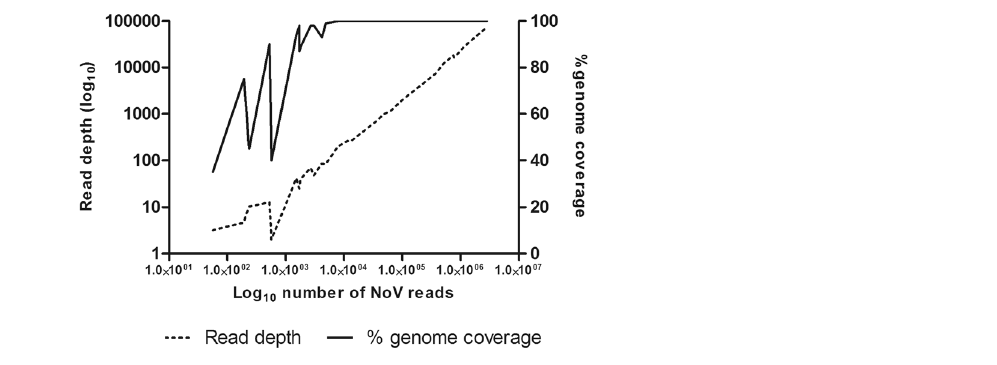
Figure 3. Relationship between the log 10 number of NoV reads (X axis) and the percentage of full-genome coverage (Y axis: solid line) and the average read depth (Y axis: dotted